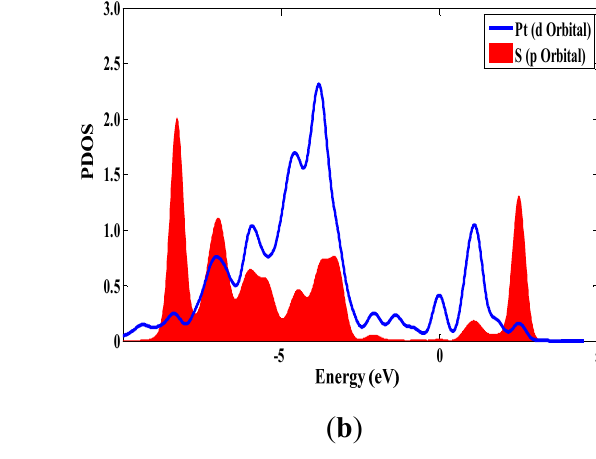
Figure 6. The density of states of H S-Pt-SWCNTs. ( a ) The DOS of H 2 the LDOS of H S in H S-Pt-SWCNTs. ( b ) The PDOS of Pt and S in H 2 2